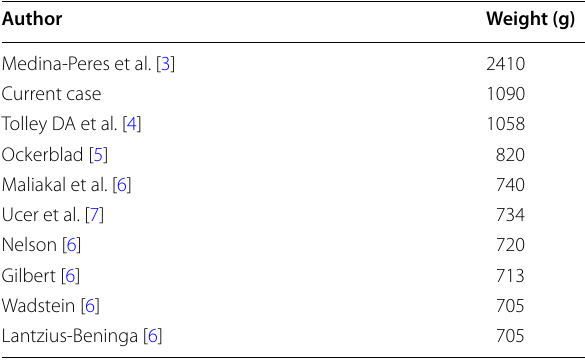
Table 1 Giant prostates exceeding 700gr in